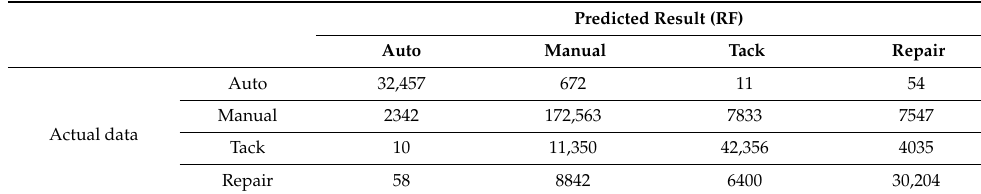
Table 4. Confusion matrix of the RF classification model.